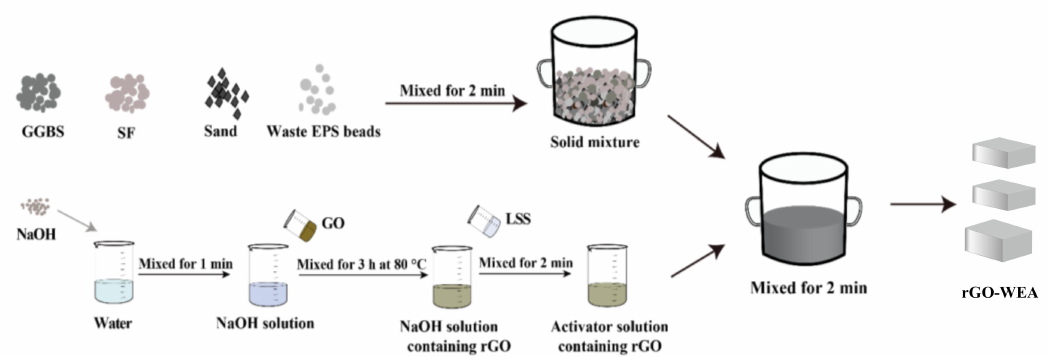
Figure 5. The rGO-WEA preparation